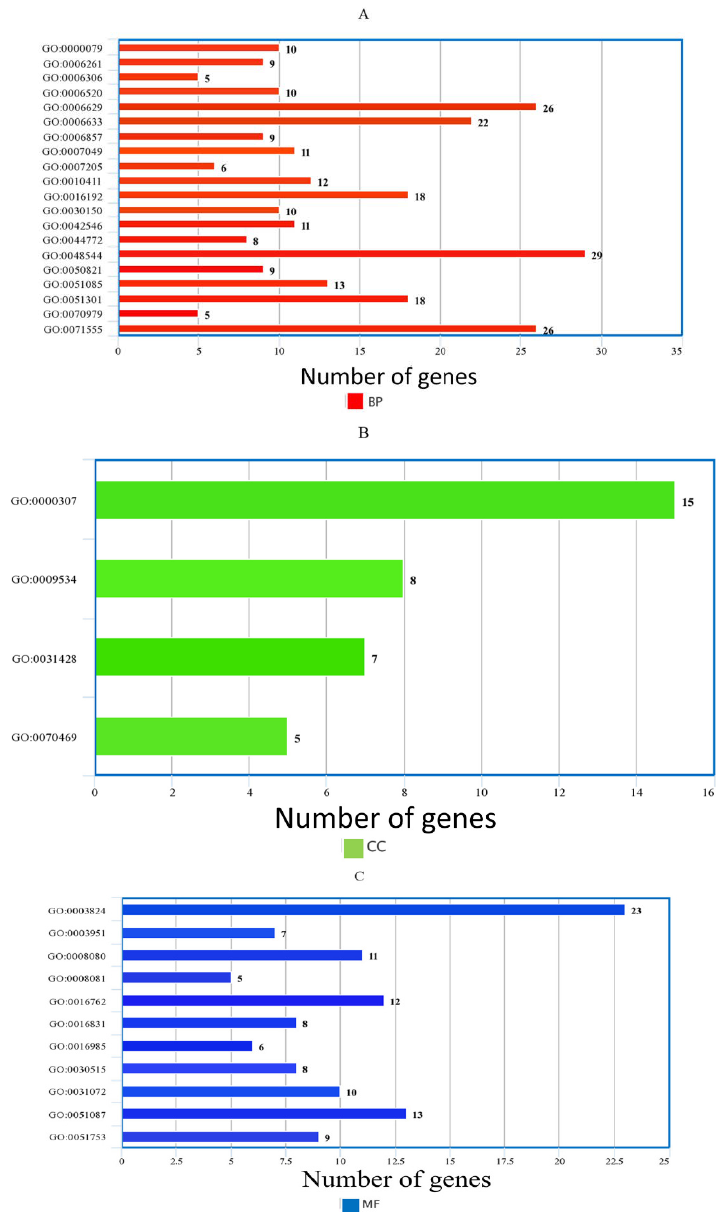
Figure 3. Bar plot of the enriched GO terms, ( A ) Biological processes, ( B ) Cellular components and ( C ) Molecular functions, using significantly expressed genes. Table 6. Distribution of the enriched GO terms in three different domains in WH-1184.